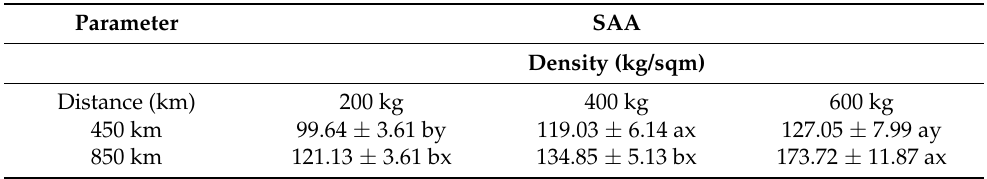
Table 11. Serum amyloid A (SAA) as affected by the interaction between density within distance in SAA subjected to road